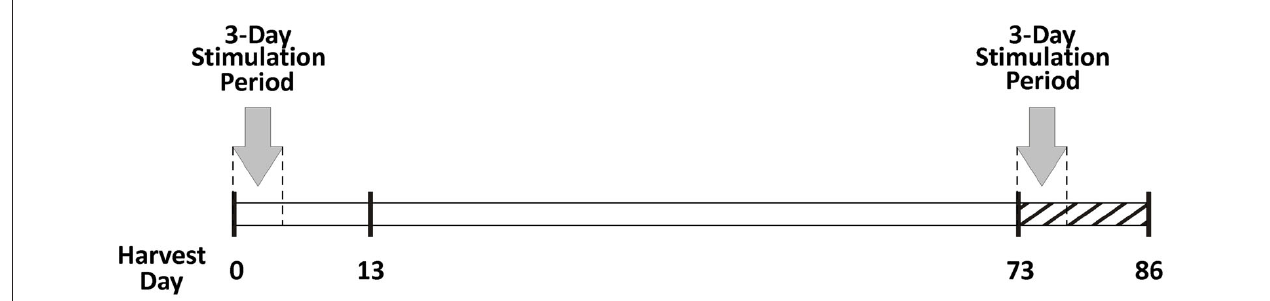
FIGURE 1 | Experimental timeline. For the unstimulated group, tissues were harvested on the equivalent of day 0. Initial stimulation involved 3 days of 48/80 injections. On day 13 from the start of the experiment, tissues were harvested for the 10 days post stimulation group. On day